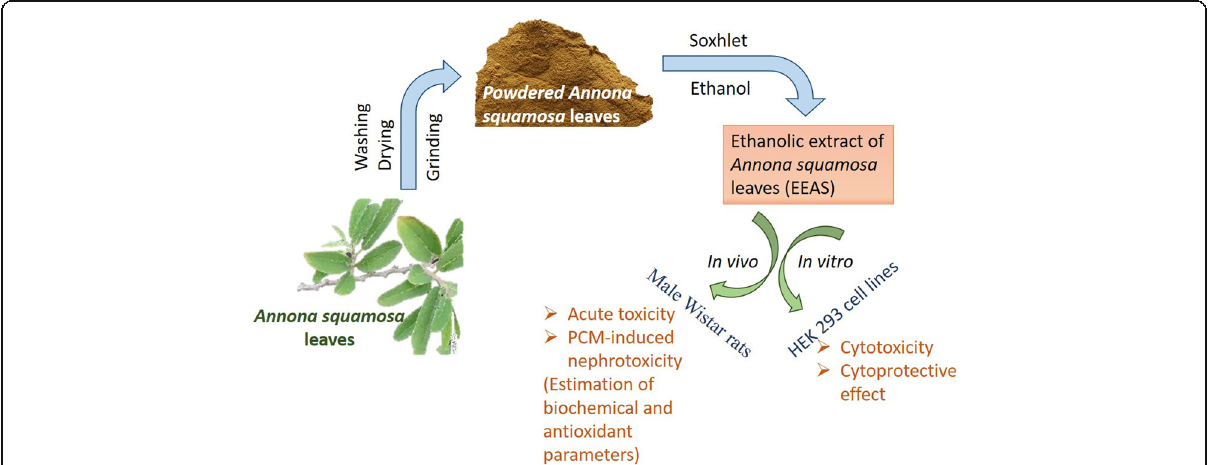
Fig. 1 Schematic representation of the overall methodology of the present